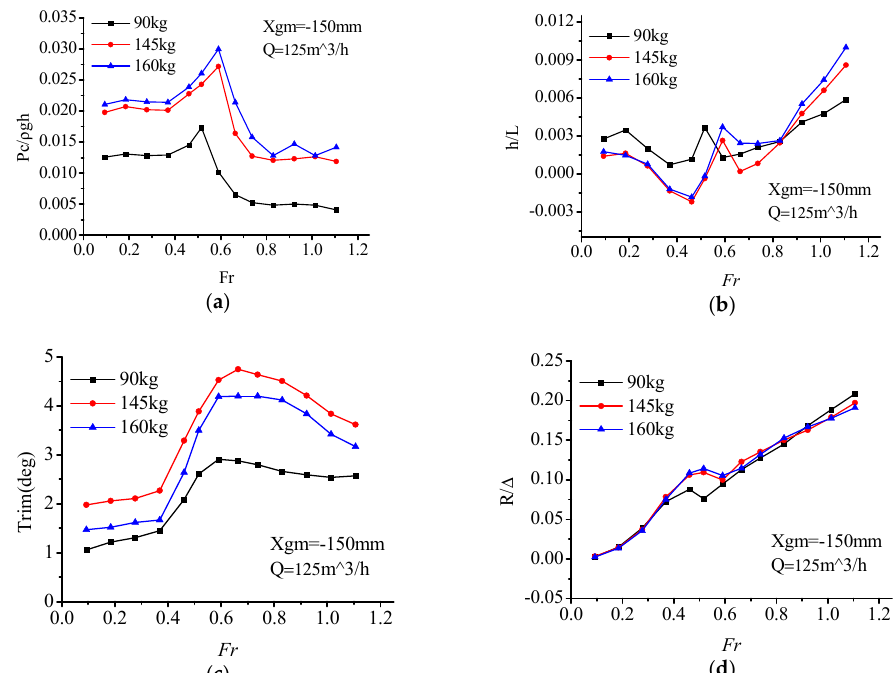
Figure A2. Comparisons of numerical and experimental results with consistent airflow Q = 125 m 3 /h.